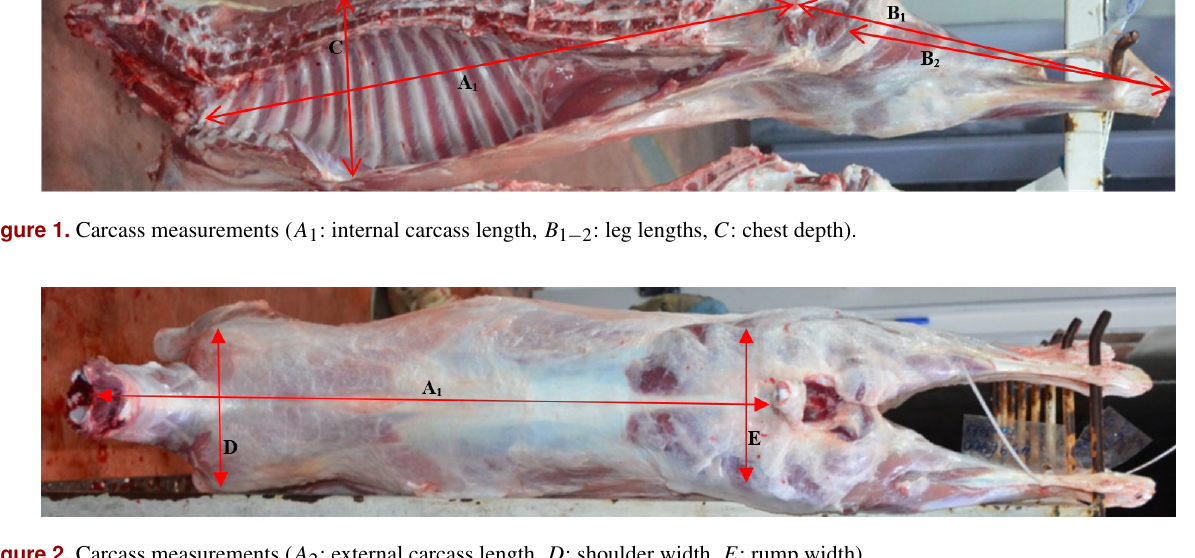
pool of the Ramlıç breed may have resulted in higher weights at birth. A similar trend supporting our findings was observed by Han et al. (2010) and Farhadian et al. (2012). The birth range of 3.70–5.00 kg reported for pure Texel and